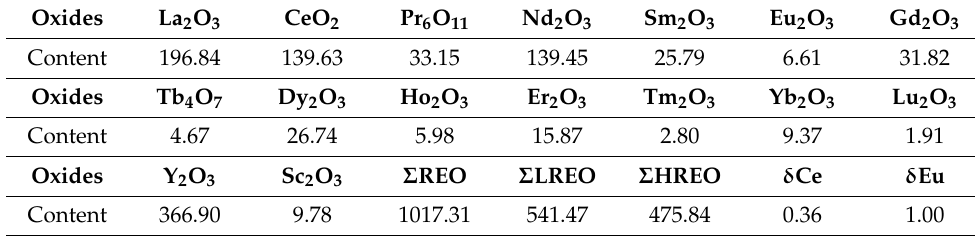
Table 2. Partitioning of REO in Zhijin phosphate ore ( × 10 − 6